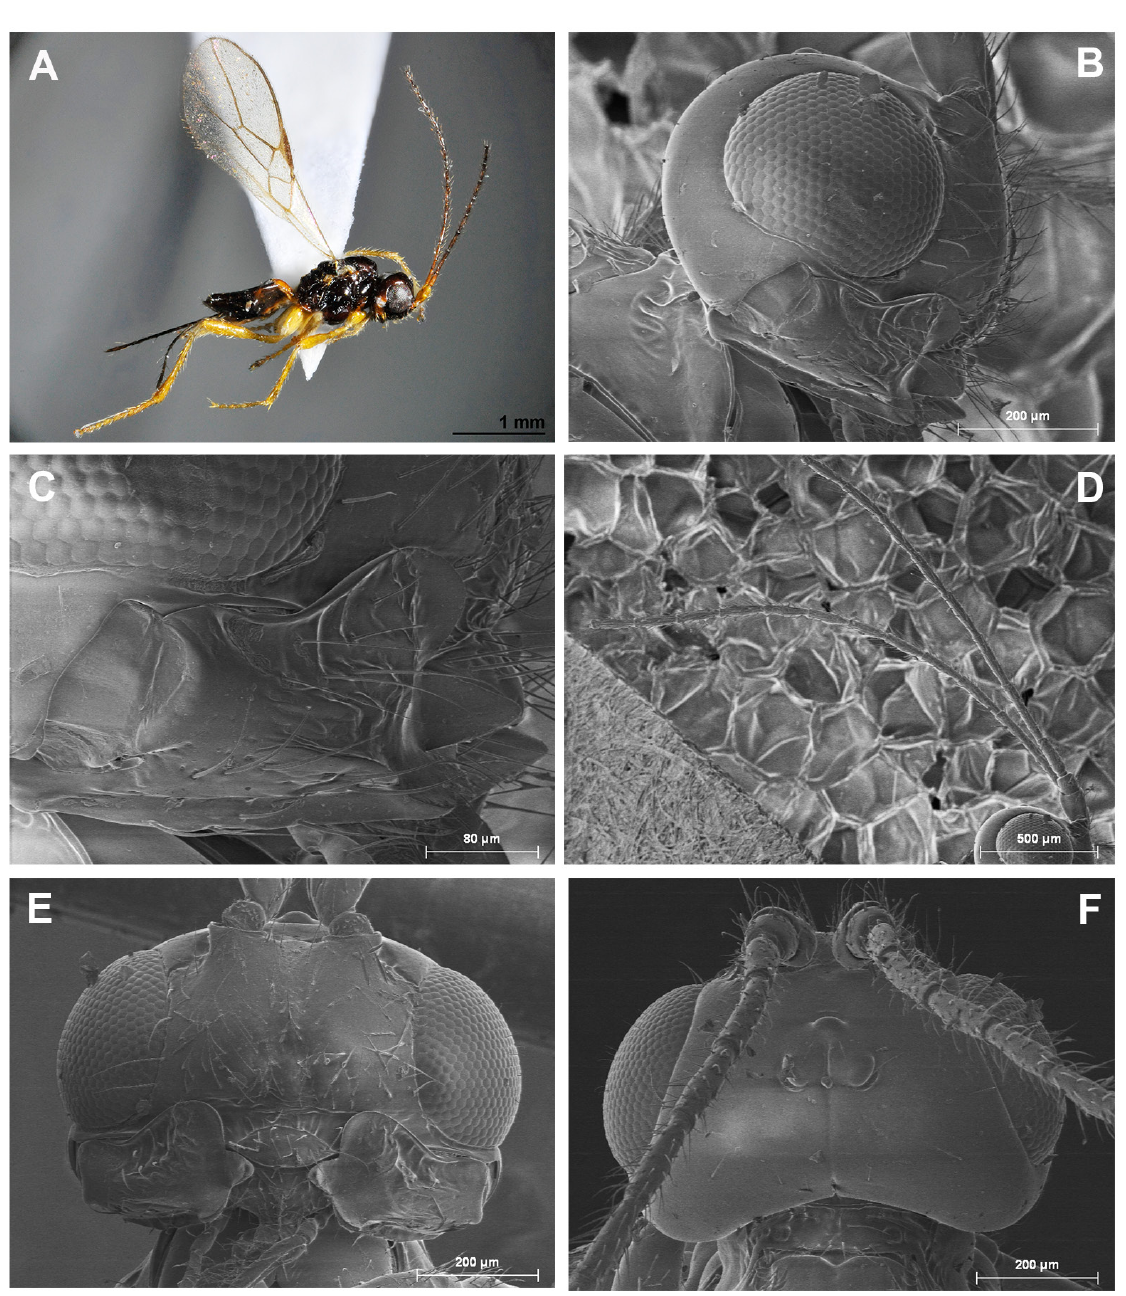
Fig. 25. Asobara kapiriensis Fischer, 2007, ♀, holotype (OLML). A . Habitus, lateral view. B . Head, lateral view. C . Mandible. D . Antenna. E . Head, front view. F . Head, dorsal